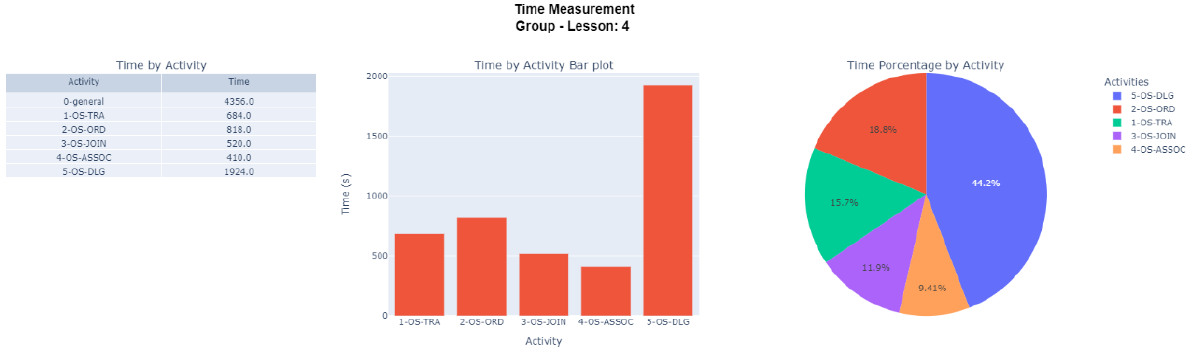
Figure 11. Group and lesson time measurements.